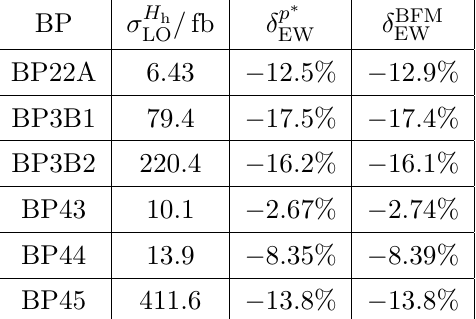
Table 10. Relative NLO corrections (cid:14) EW to heavy Higgs-boson H h production in Higgs strahlung pp H h (cid:22) (cid:0) (cid:22) + in the 2HDM. No results for the MS scheme are presented due to large scale ! uncertainties exceeding 100%.